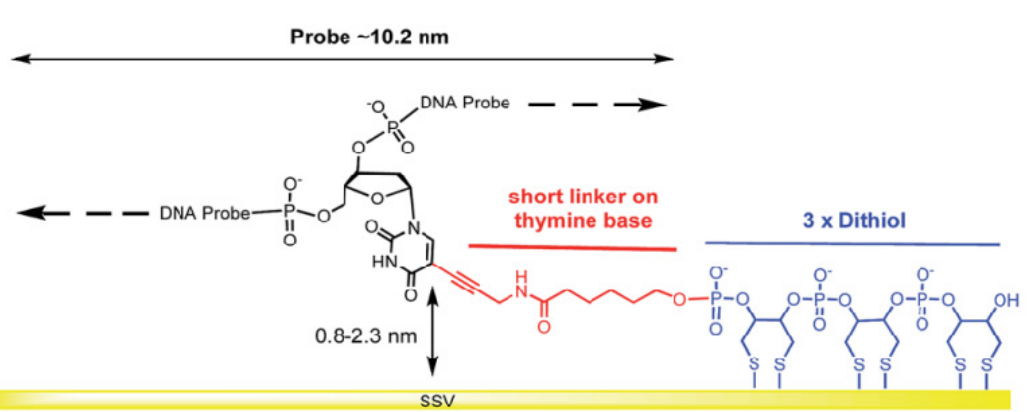
Figure 10. Self-assembled monolayer of 30-mer ssDNA probes on a gold sphere segment void (Au SSV) surface via three dithiols as a surface anchor that promotes horizontal orientation of dsDNA molecules. This figure has been adapted from Bartlett and his group [51], under Attribution 3.0 Unported (CC BY 3.0)